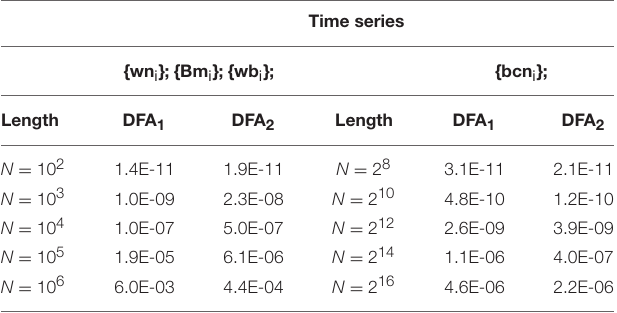
TABLE 1 | Largest relative error in F q (n) estimates induced by calculating the sum of n products with the fast Equation (15).